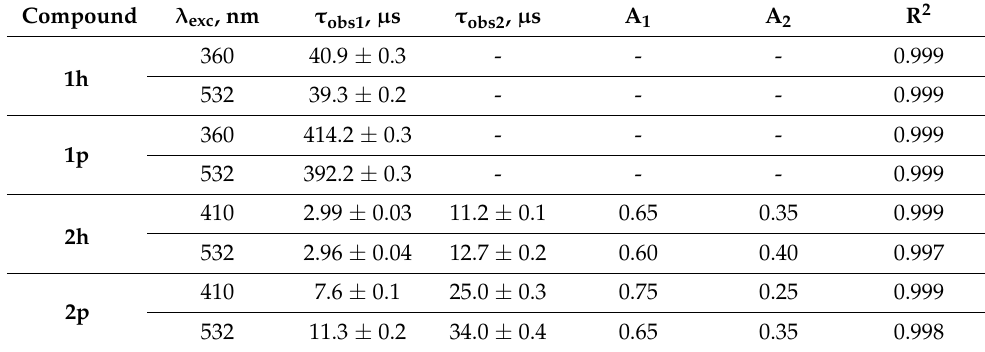
Table 3. Luminescence decay times for solid complexes at room temperature. Compound